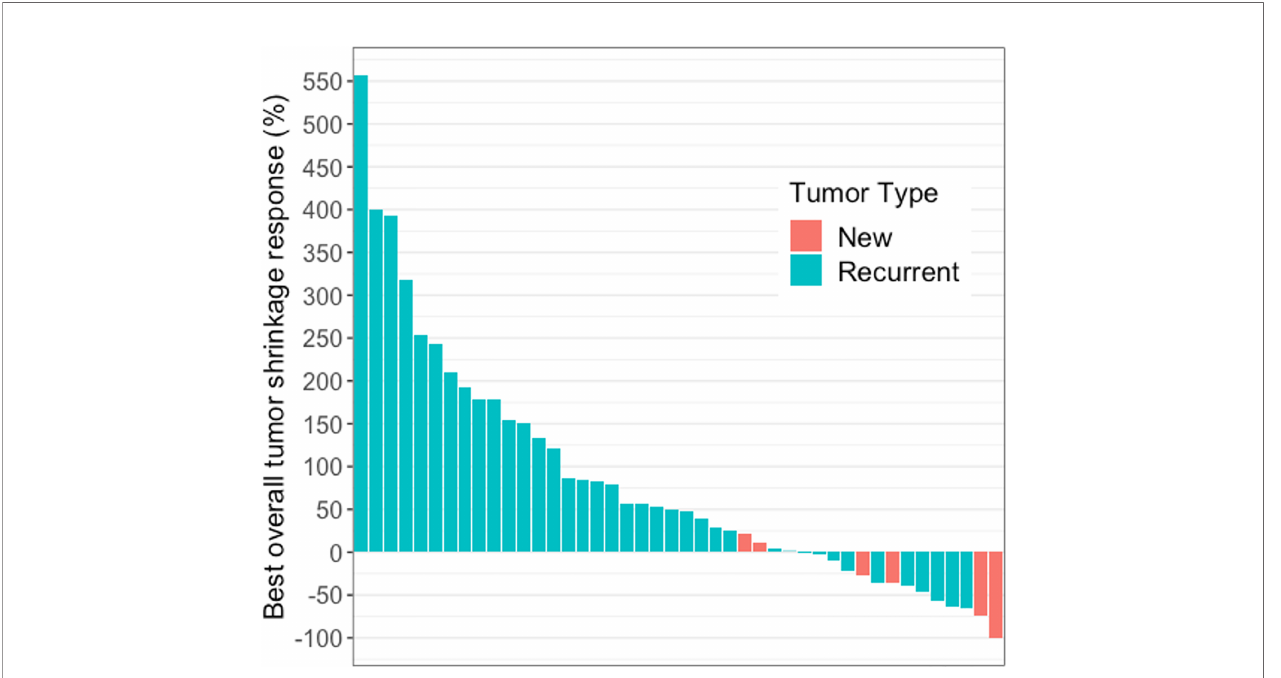
FIGURE 1 | Waterfall plot showing best overall tumor shrinkage in the form of percentage change in enhancing lesion size compared to baseline in 44 of 49 patients with glioblastoma receiving immune checkpoint blockade. These 44 patients had measurable disease at baseline and the change in enhancing lesion burden at